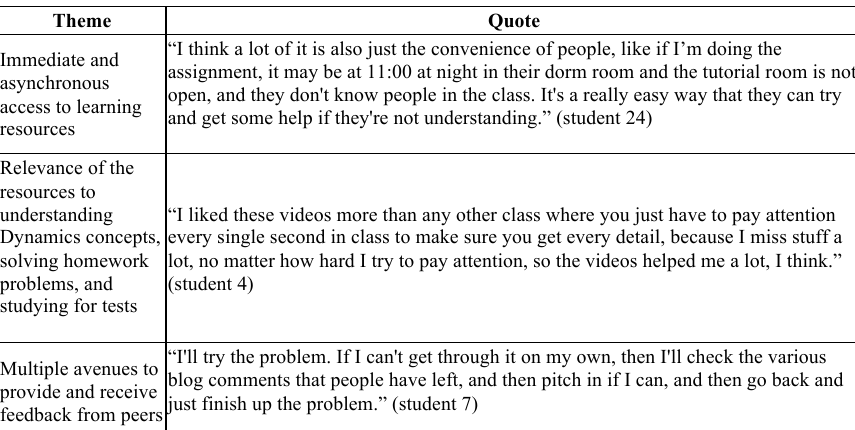
Students’ characterizations of the utility of Freeform